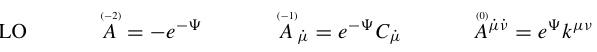
Table 5 The leading order gravitational potentials in torsion free gauge